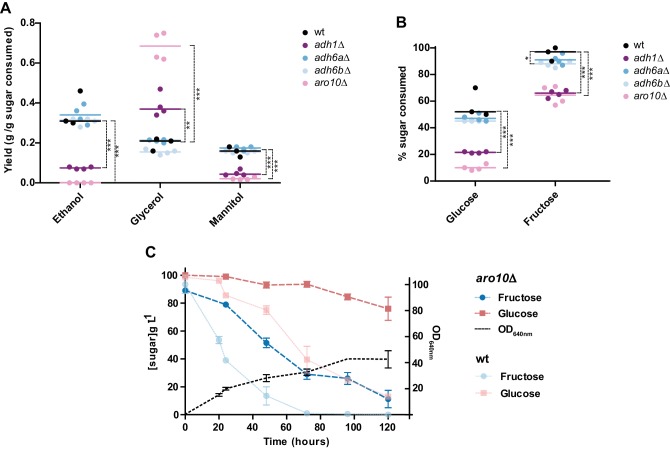
Metabolite production and sugar consumption in St. bombicola wild type (wt) and deletion mutants (adh1Δ, adh6aΔ, adh6bΔ, and aro10Δ).(A) Ethanol, glycerol, and mannitol yields determined after 72 hr of growth. (B) Percentage of sugar (fructose and glucose) consumed after 72 hr of growth. Mean values are represented by the colored horizontal lines. Assays were performed in duplicate in two biological replicates. All strains were grown in 20FG medium at 30°C with aeration. Statistically significant differences (one way ANOVA, using the Bonferroni’s correction) between wt and deletion mutants for sugar consumption and metabolite production are shown (* p-value<0.05; ** p-value<0.01; *** p-value<0.001). Additional p-values for other pairwise comparisons are shown in Figure 7—source data 1. (C) Sugar consumption profile of aro10∆ mutant grown in 20FG medium. Sugar consumption profile is also shown for the wt strain as indicated in the key and was previously reported in Figure 1. Error bars represent standard deviation of assays performed in duplicate in two biological replicates.10.7554/eLife.33034.021Figure 7—source data 1.p-Values and data used to construct the plots.10.7554/eLife.33034.022Figure 7—source data 2.Primers and strategies used to construct the deletion mutants.